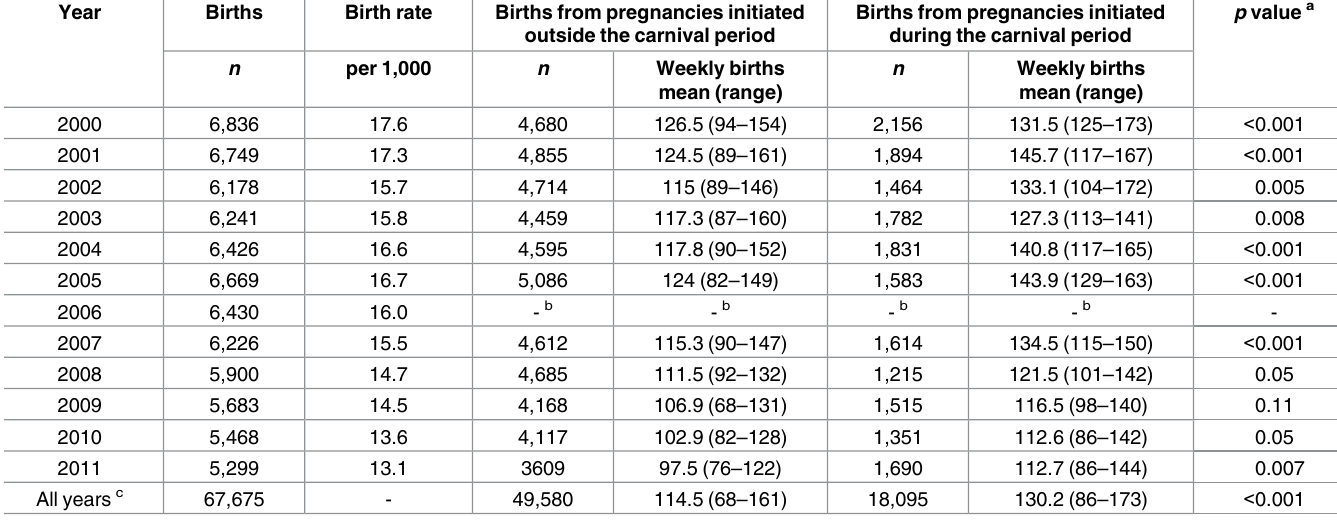
Table 1. Weekly number of births occurring during and outside the birth period for carnival pregnancies from January 1 2000 to December31 2011 in Guadeloupe (French West Indies).